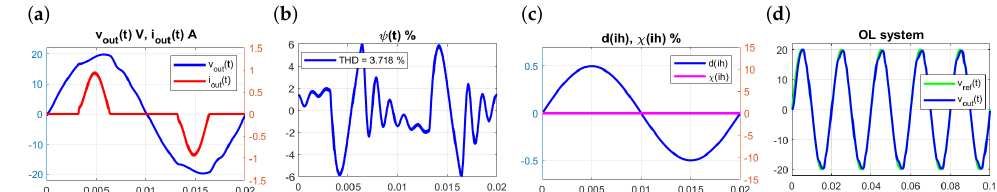
Figure 29. Control in the OL system with rectifier RC load. ( a – c ) steady-state variables, ( d ) start-up process. Note that the start-up process is very fast.